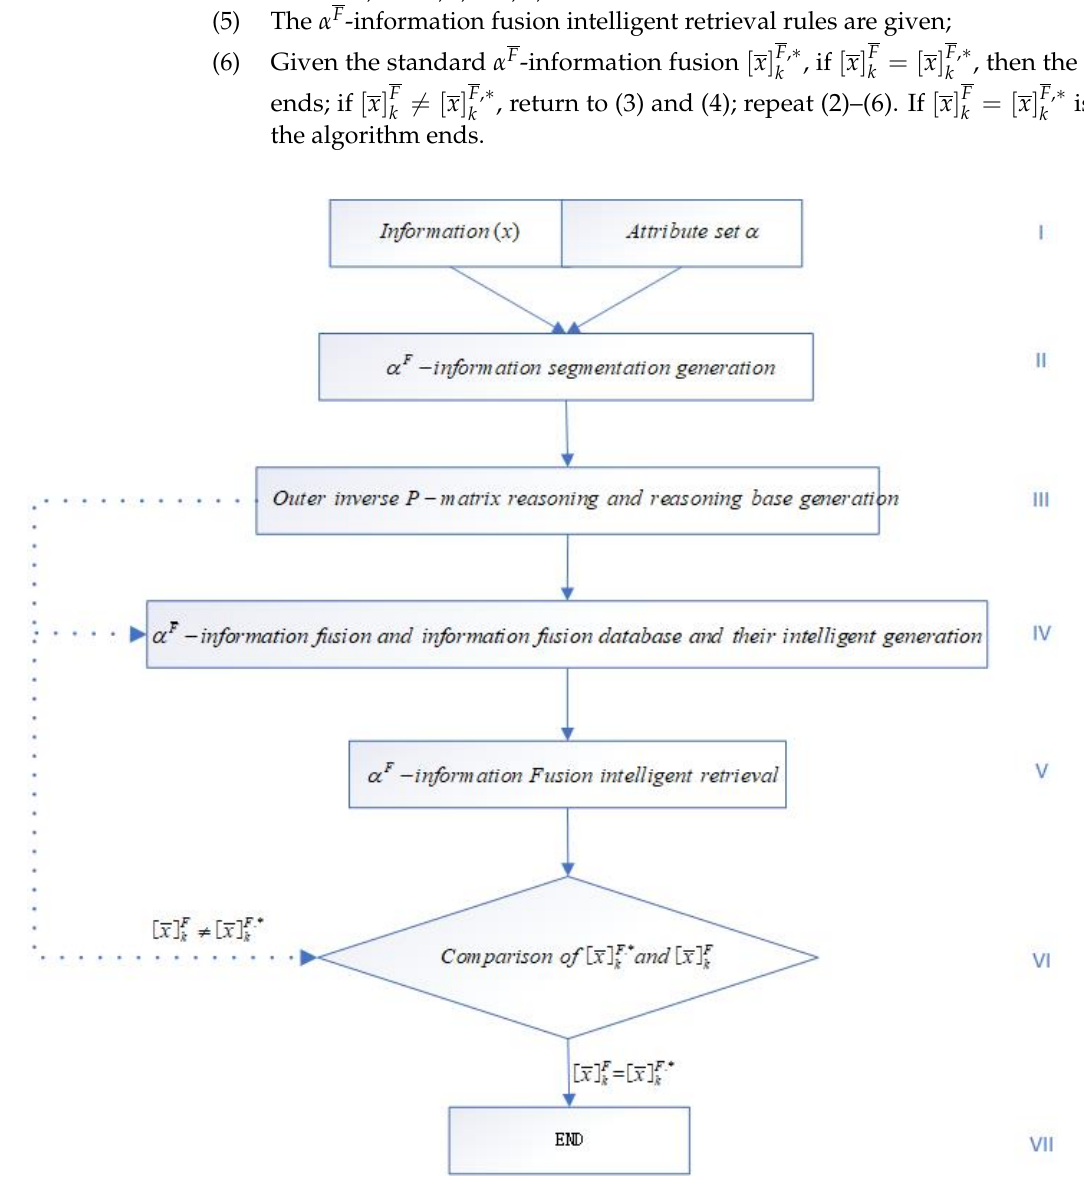
α Figure 1. F -information fusion intelligent acquisition intelligent retrieval algorithm. Figure 1. α F -information fusion intelligent acquisition intelligent retrieval